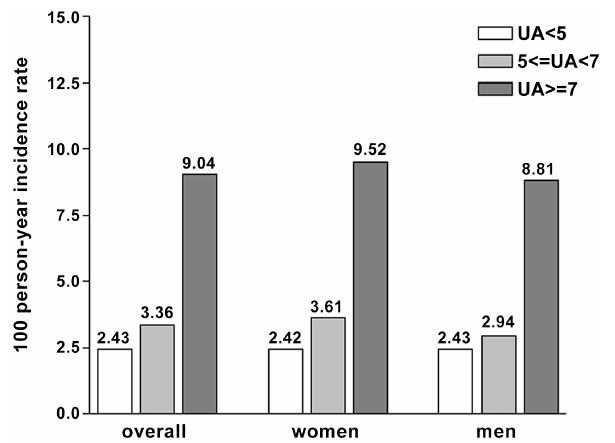
Figure 1. Overall and Sex-specific person year incidence rate of new-onset micro-albuminuria in three serum uric acid tertiles (5 mg/dL or less, 5–7 mg/dL, more than 7 mg/dL) during the four years of follow-up. Conversion factor for uric acid in mg/dL to